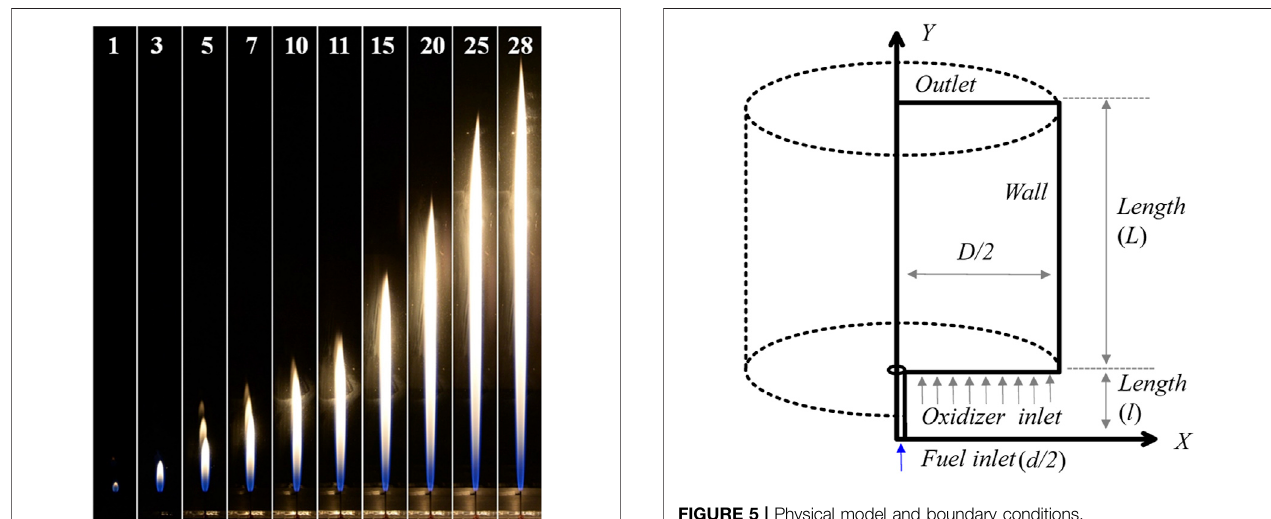
FIGURE 5 | Physical model and boundary